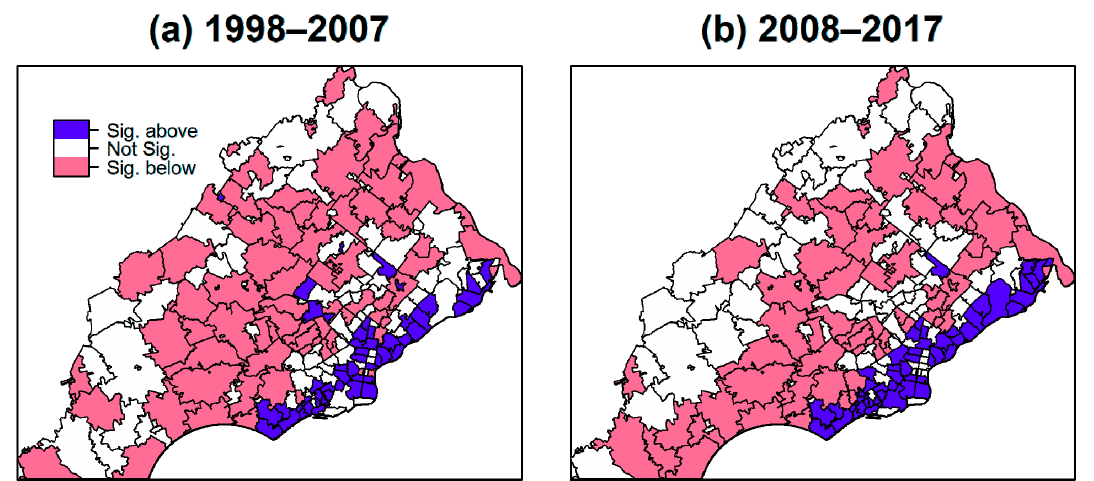
Figure 4. ZIP codes with age-adjusted incidence rates significantly higher than the age-adjusted PA state rates for ( a ) 1998 to 2007 period, and ( b ) 2008 to 2017 period.